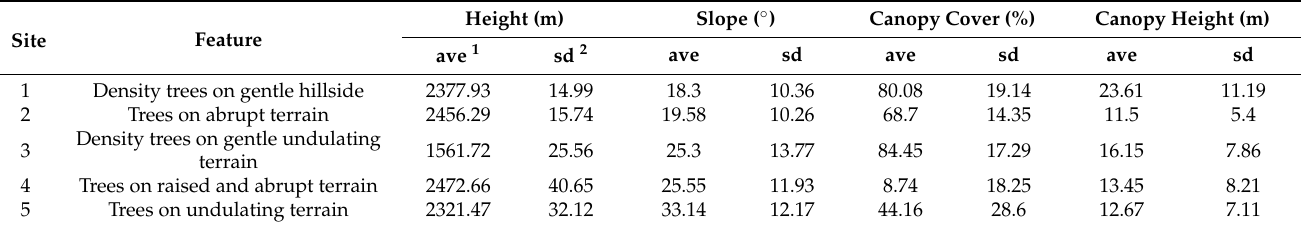
Table 2. Descriptions and statistics of the five forested sites.